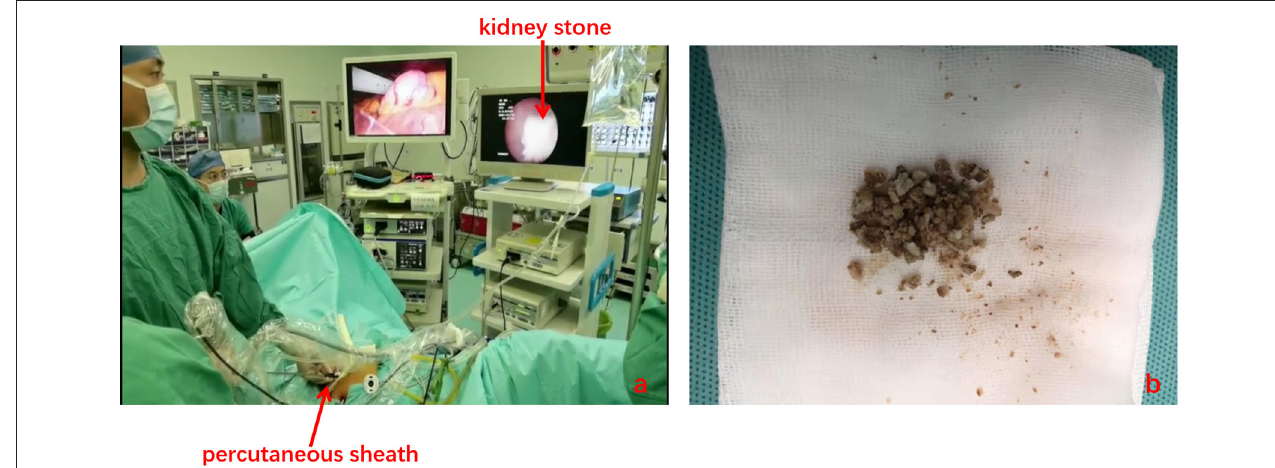
FIGURE 4 | Lithotripsy is performed with the combination of the laparoscope and ureteroscope (a) . Kidney stone sample (b) .